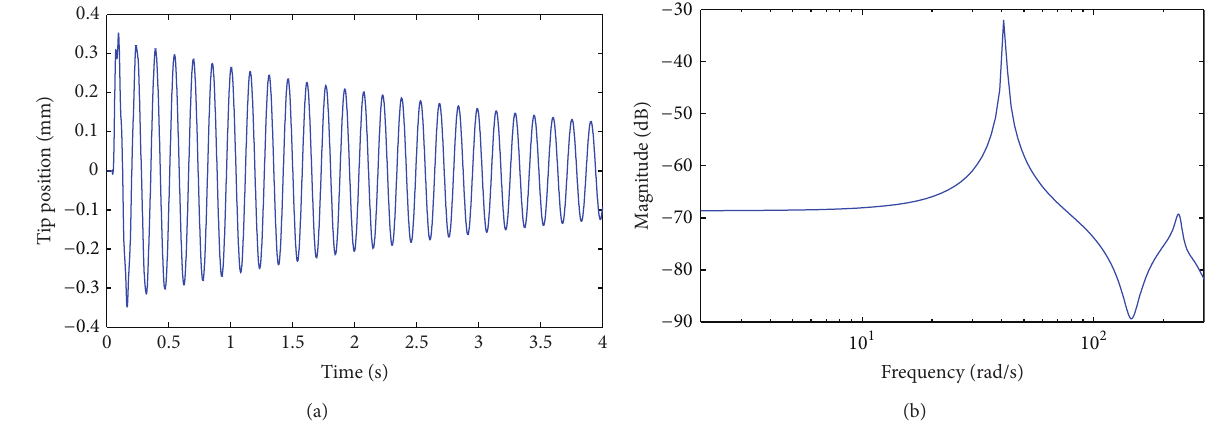
Figure 4: System’s responses based on FE model: (a) pulse response, (b) frequency response